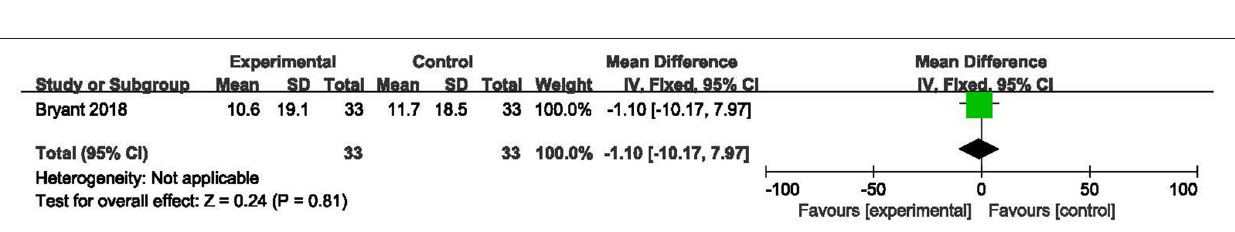
FIGURE 7 | Forest plot of network meta-analysis of the end-of-treatment effect on depression severity between cognitive behavioral therapy-long and no treatment.